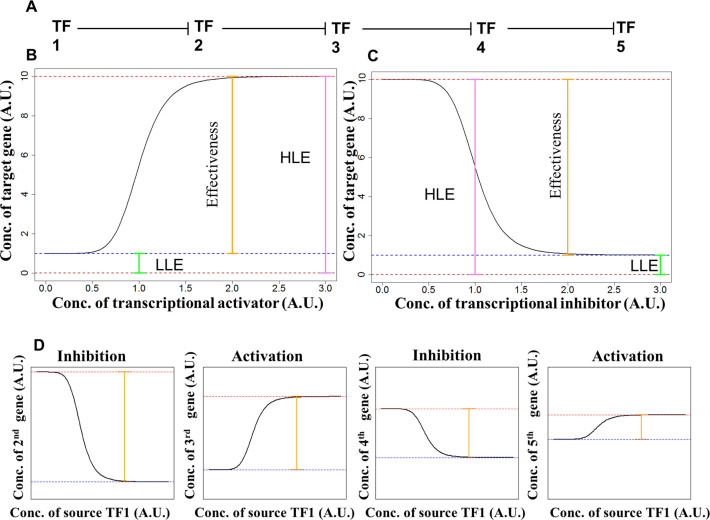
Dynamics of long regulatory chains (LRC). (A) Schematic of a five gene LRC formed by inhibitory transcriptional regulations. (B) Net transcriptional activation. The figures summarize the salient features of transcriptional activation. The concentration of a target gene (y axis, arbitrary units) varies as a function of the concentration of an upstream transcriptional activator (x axis, arbitrary units). Three features used to summarize the dynamics of transcriptional response are highlighted: the effectiveness is reported by the orange line, the highest level of expression (HLE) is reported by the pink line, and the lowest level of expression (LLE) is reported by the green line. (C) Net transcriptional inhibition. The salient feature of a transcriptional inhibition is reported using the same conventions of panel B. (D) Net response in an LRC of transcriptional inhibitors. Responses of the genes in an LRC formed by transcriptional inhibitors are reported using conventions comparable to those of panels (B) and (C). Note (i) how inhibition and activation alternate and (ii) the changes in LLE (dotted blue line), HLE (dotted red line), and effectiveness (orange line).